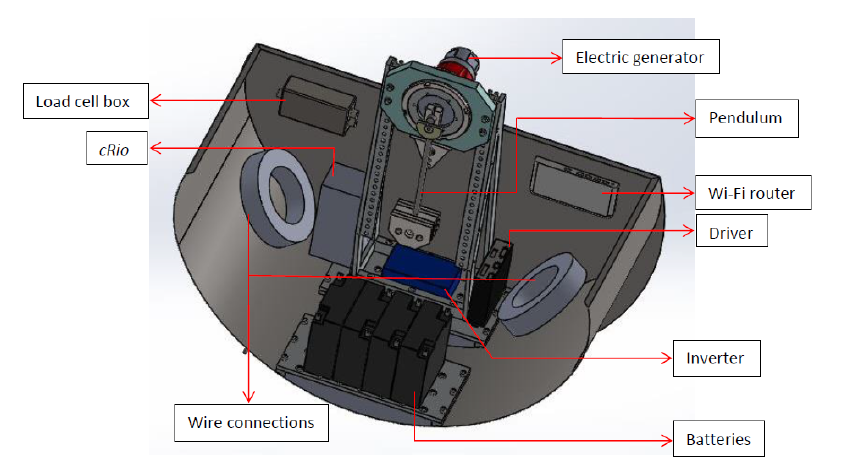
Figure 2. Digital representation of the 1:45 PeWEC prototype and its subcomponents.